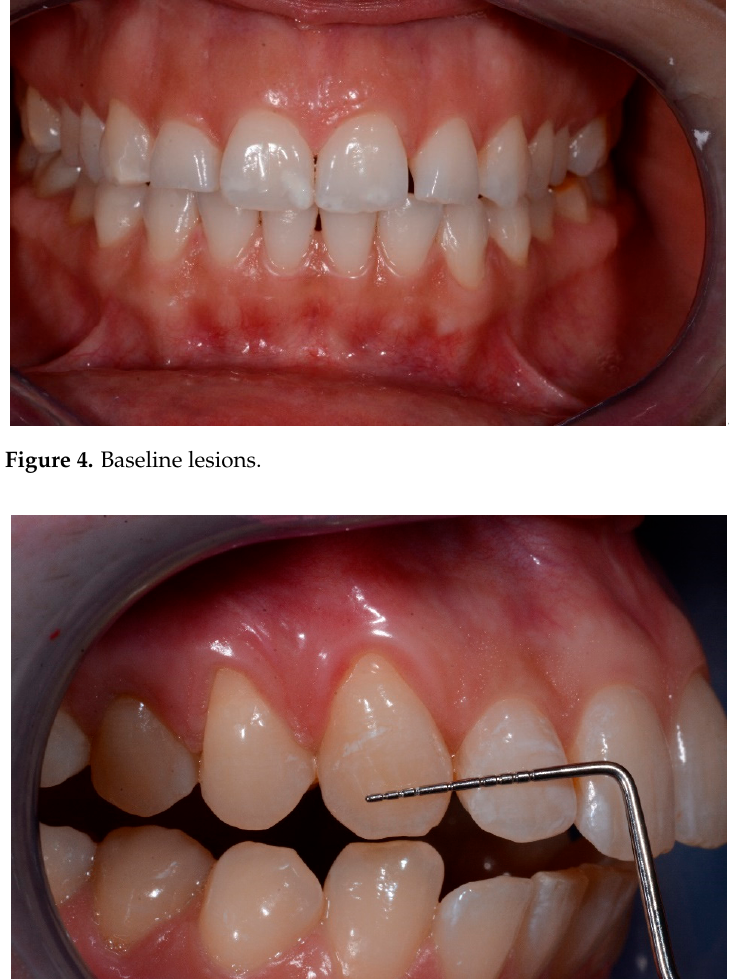
Figure 7. t1 lesion with the periodontal probe . Figure 5. Baseline lesion with the periodontal probe. Medicina 2020 , 56 , x FOR PEER REVIEW - every 3 months during the observation period (t2, t3, t4) (Figures 8 and 9)